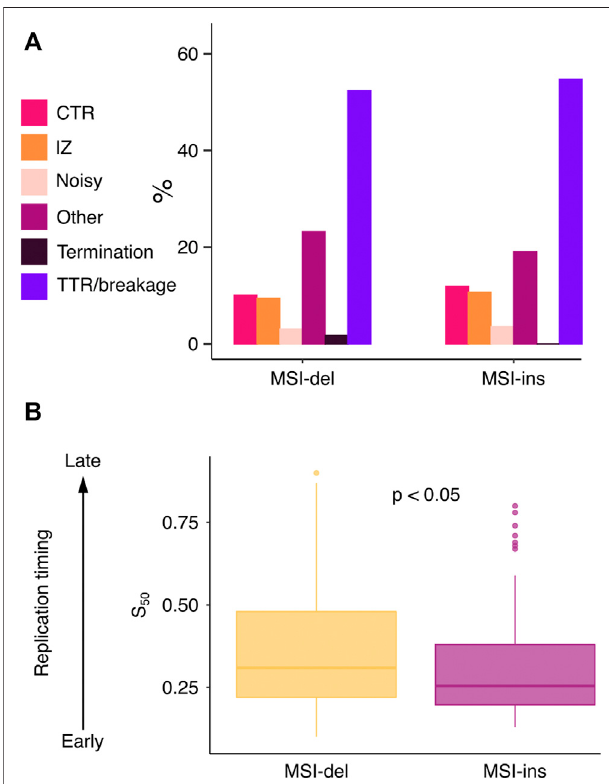
FIGURE5| DeletionsandinsertionsareassociatedwithdifferentialDNA replication time windows. (A) Barplot of the number of replication features identi fi edatMSItargetgenes. (B) MSI-delgenesarereplicatedlaterinSphase compared to MSI-ins genes ( p = 0.023). S 50 values were tested using two-tailed Mann-Whitney